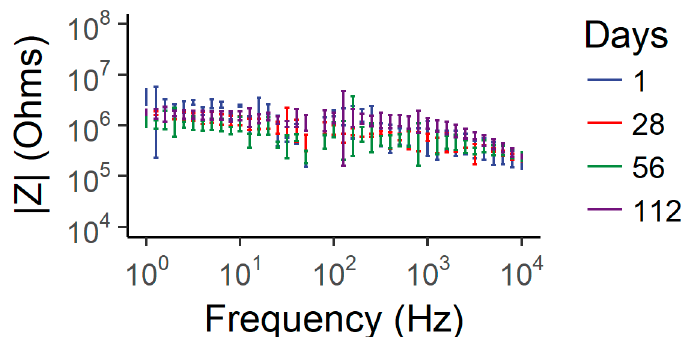
Figure 7. Comparison of impedance magnitude spectra from EIS over the 16-week implant